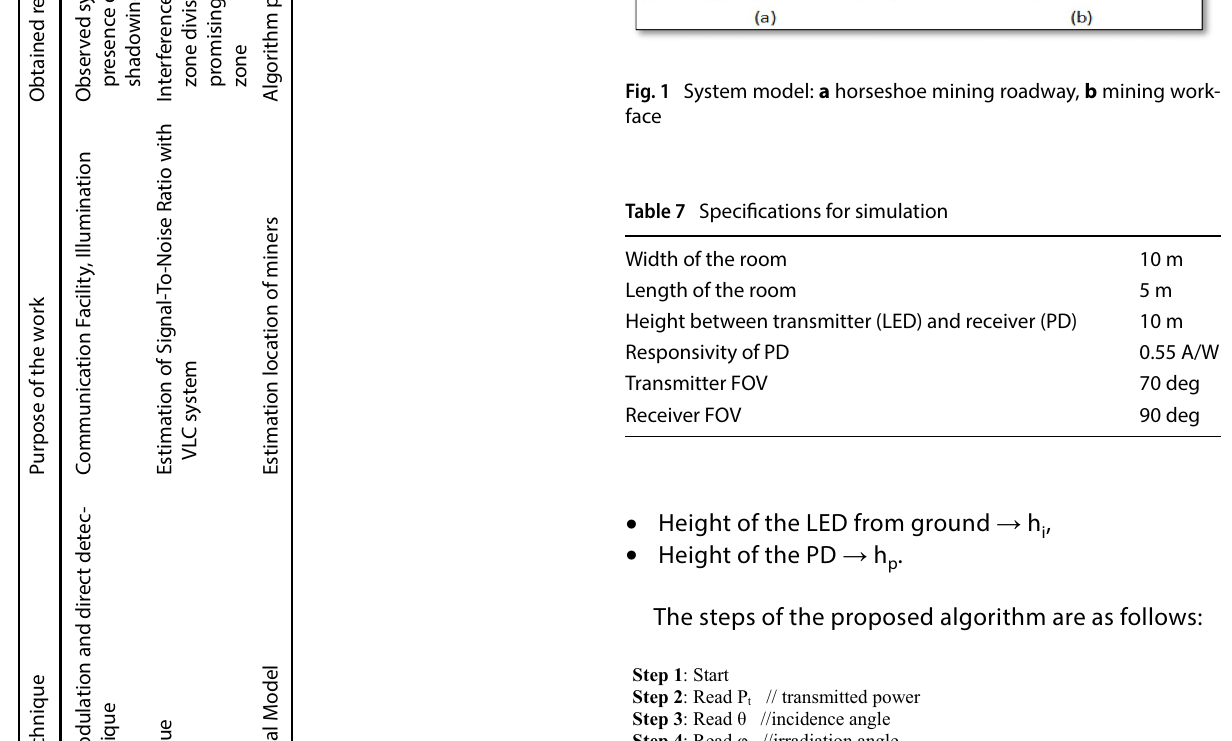
//Lambertian emission order )